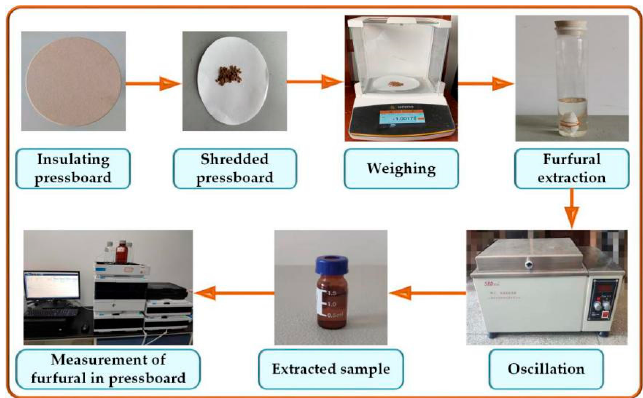
Figure 3. Measurement of furfural concentration in pressboard.